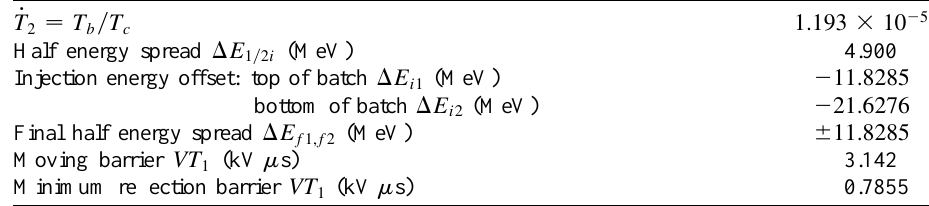
TABLE II. Some parameters in the simulations of this injection method from the Fermilab Booster to the Main Injector. (cid:2) T 2 (cid:1) T b (cid:1) T c